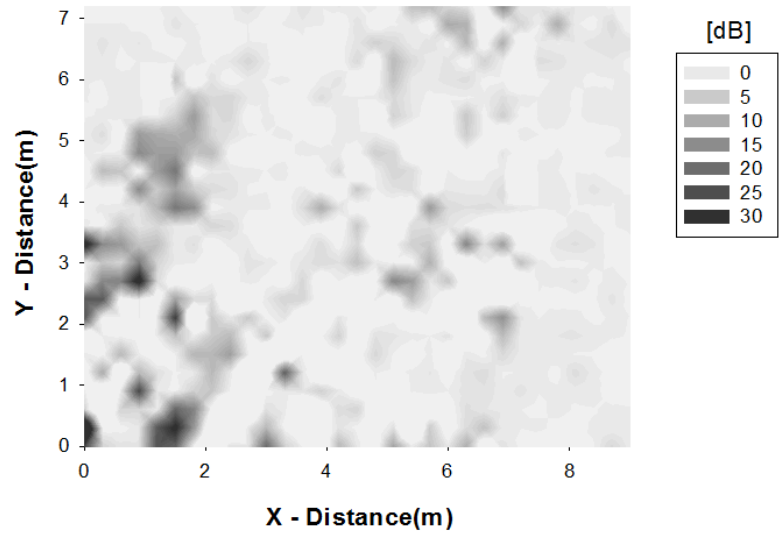
Figure 6. Comparison of receiver power when human body models are introduced in the home.